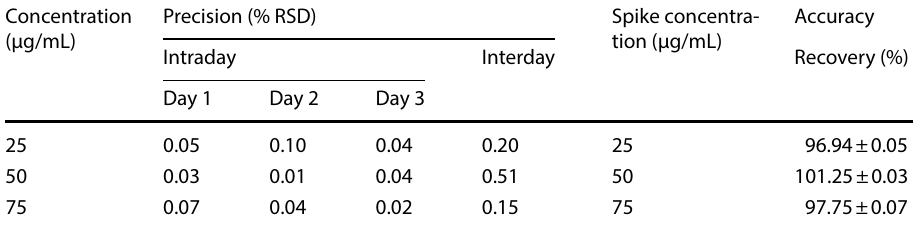
Fig. 3 UV spectrums of a standard trans -anethole (top of the peak) and trans -anethole in the extract at b top, c upslope, and d downslope. The similarity between the UV spectrums of the three